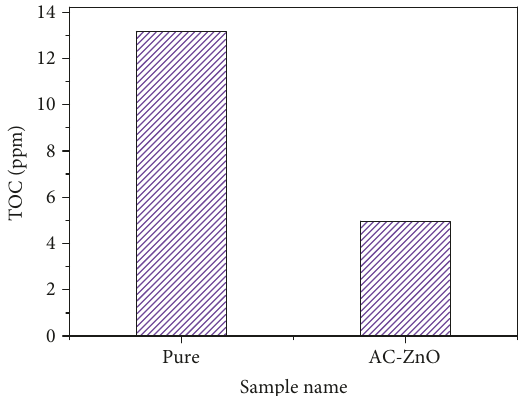
Figure 9: TOC of EV ( C = 20ppm ) before and after 120min. of 0 degradation using AC-ZnO under